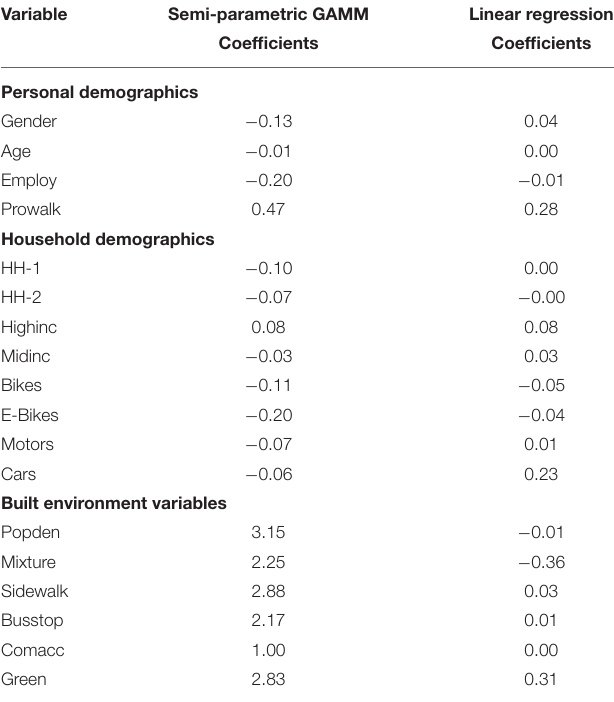
TABLE 6 | Comparison between semi-parametric GAMM and linear